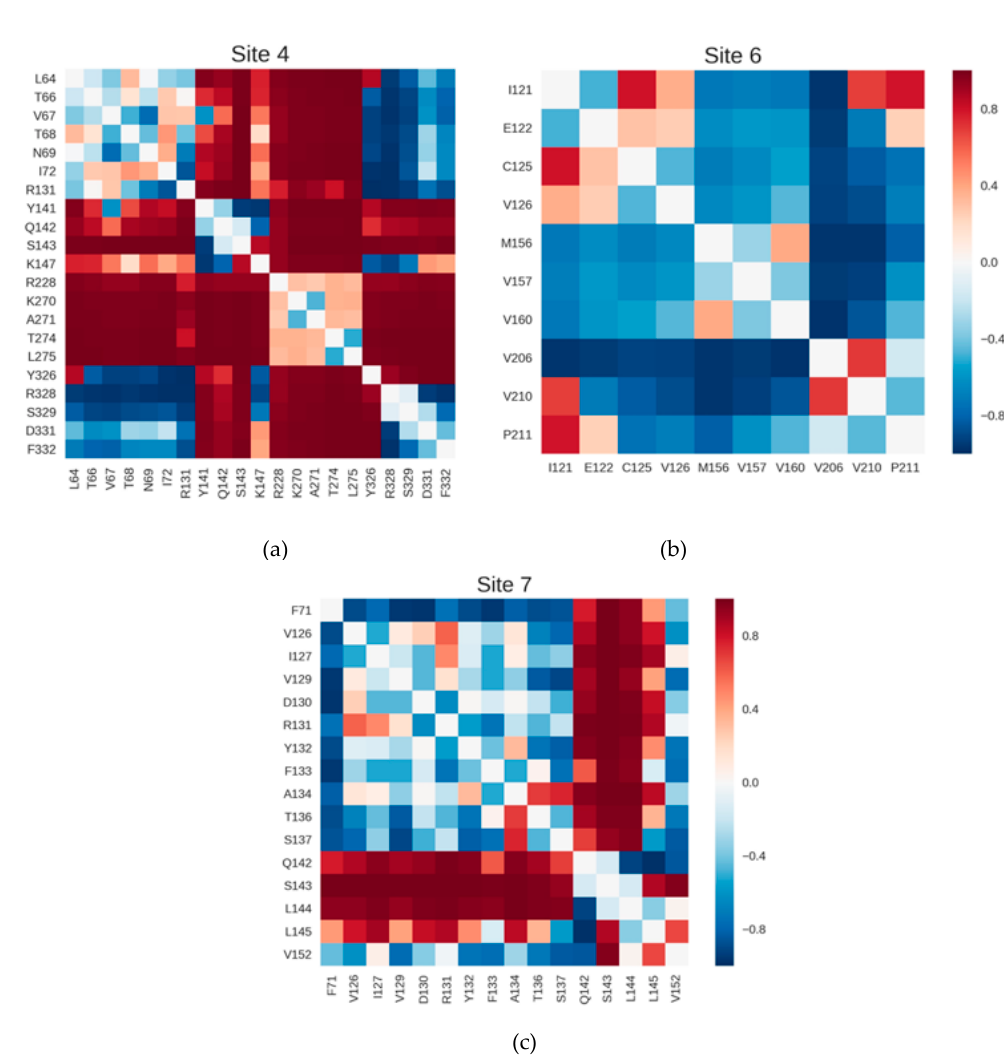
Figure 5. Matrices of correlations between inter-residue distances and ∆ for top-ranked sites in the β 2AR. ( a ) Site 4; ( b ) Site 6; ( c ) Site 7. These sites show strong coupling to ∆ and correspond to known allosteric sites. Each element cij in these matrices is the correlation coefficient between ∆ and the distance between residues i and j. Strong anti-correlations are in blue, intermediate values in white and strong correlations in red.